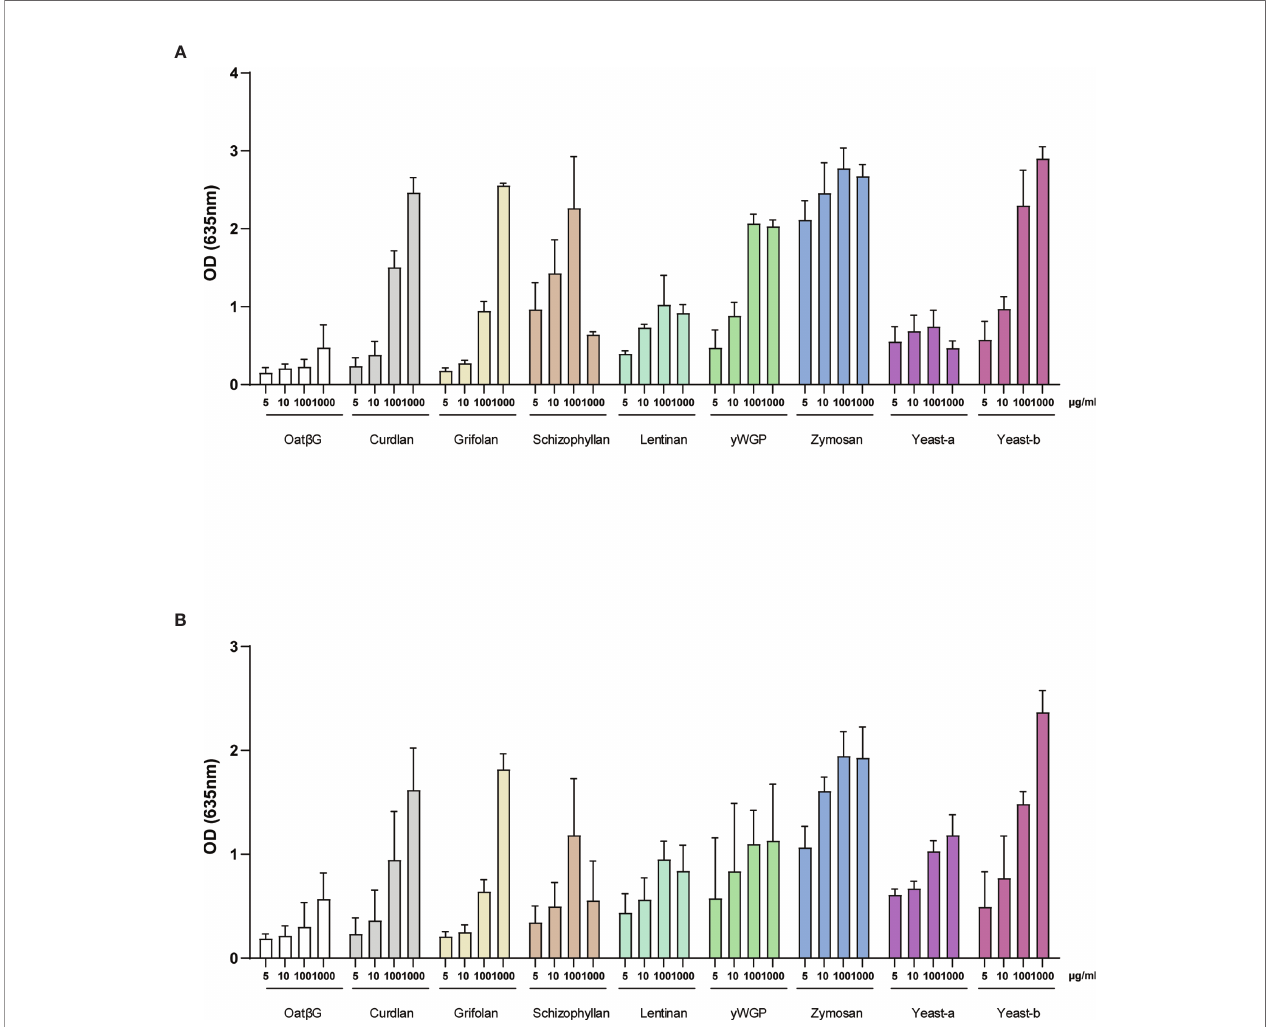
FIGURE 5 | Activation of Dectin-1a and b isoforms by yeast-b, zymosan, curdlan, yWGP, lentinan, schizophyllan and yeast-a. HEK- Blue ™ - Dectin-1a (A) and HEK- Blue ™ - Dectin-1b (B) were stimulated with 5, 10, 100 and 1000 µg/ml of b -glucans. After 24 h of stimulation, the secretion of SEAP was quanti fi ed in cell-free supernatants. Results of SEAP activity analysis are shown in a bar graph as average values ± SD of absorbance at 635 nm from n = 3 independent